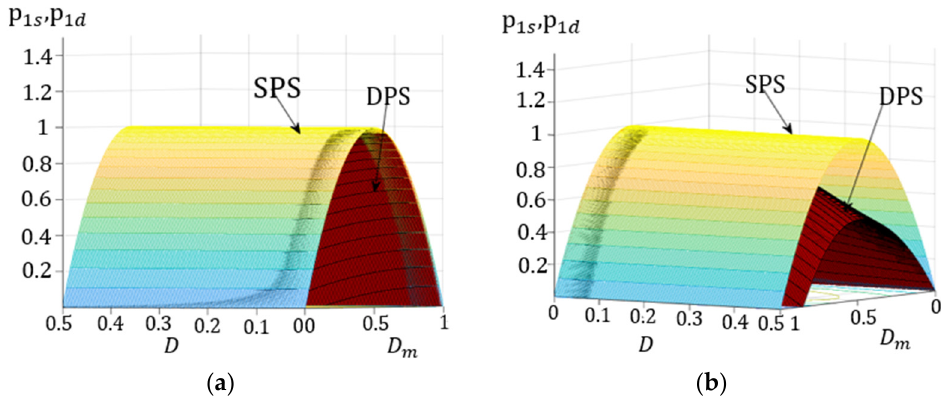
Figure 7. Unified powers at port 1 for both SPS and DPS control schemes ( a ) front and ( b ) rear view.